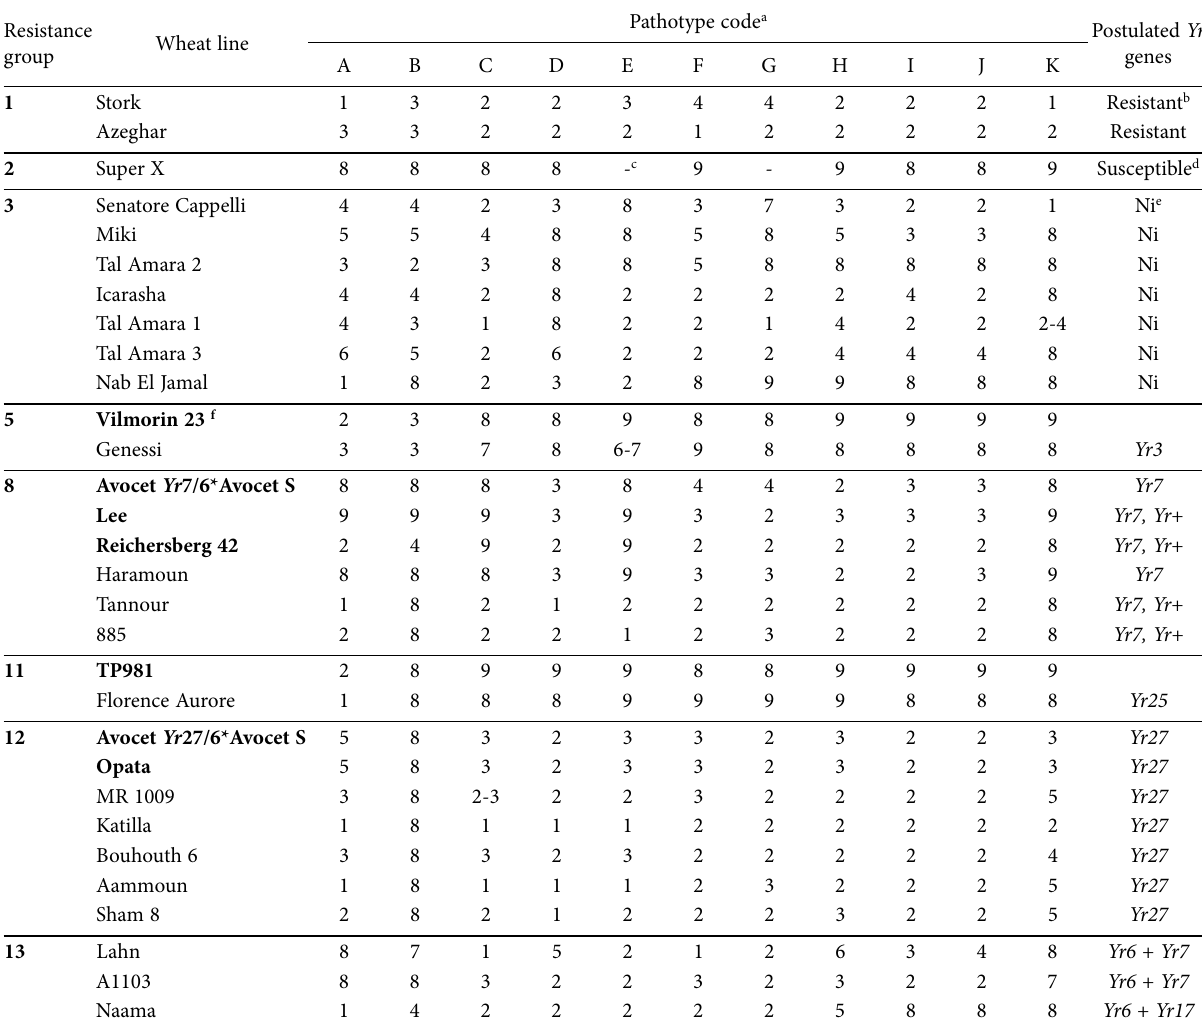
Table 3. Resistance group, infection type and postulated seedling-stage stripe rust resistance genes against 11 Puccinia striiformis f. sp. tritici pathotypes, for 23 Lebanese wheat